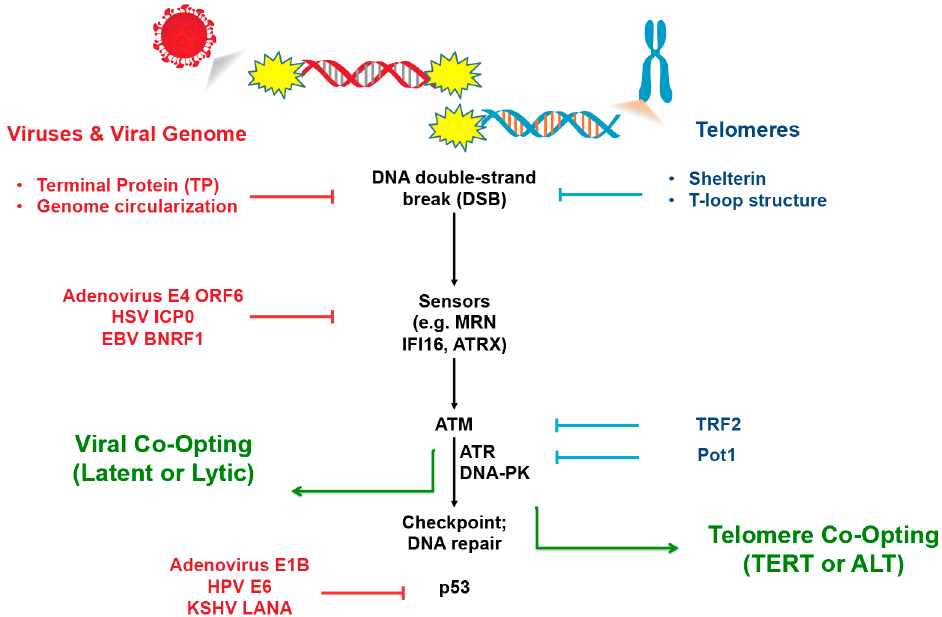
Figure 1. Strategies in suppressing or co-opting DNA Damage Response (DDR). DDR factors can suppress viral infection by inducing a checkpoint response culminating in p53 activation. Viral proteins, like adenovirus terminal protein (Ad TP) or E4 open reading frame (ORF)6, can prevent the DDR response at early stages, while other viral proteins block later events, such as the p53 function. Telomeric factors, such as TRF2 and Pot1, can also suppress DDR at telomeres. Both viruses and telomeres can co-opt DDR factors to replicate and maintain their genomes. TERT: telomerase protein subunit; ALT: alternative lengthening of telomeres; ATM: ataxia-telangectasia mutated; ATR: ATM-related; DNA-PK: DNA-protein kinase; MRN: MRE11-RAD50-NBS1 complex; HSV ICP0: herpes simplex 1 infected cell protein 0; EBV BNRF1:Epstein-Barr Virus BNRF1.